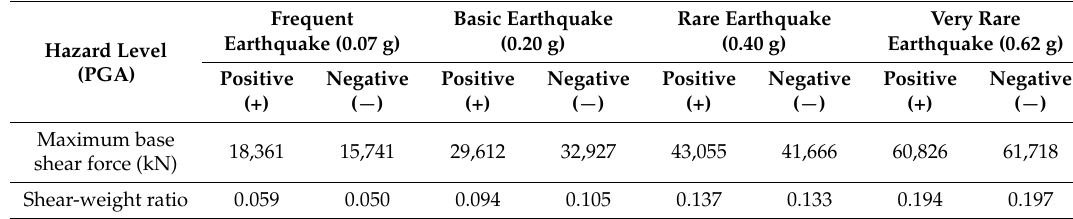
Table 3. Maximum base shear forces and shear-weight ratios.